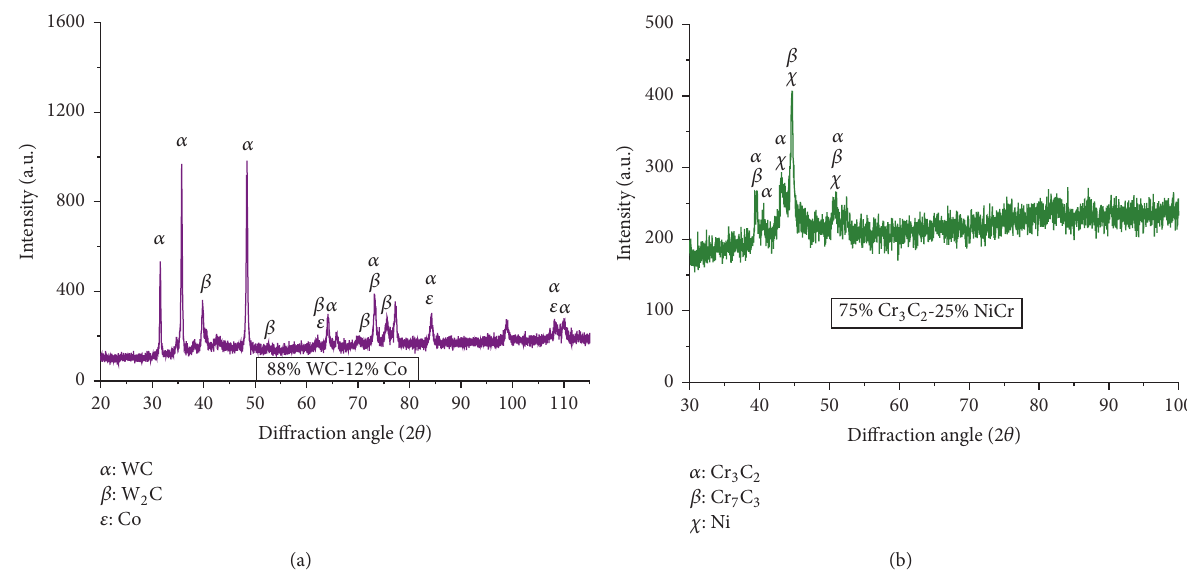
Figure 4: X-ray diffraction patterns of D-Gun sprayed (a) WC-12% Co; (b) Cr 3 C 2 -25% NiCr coating on an ASTM A36 steel substrate.